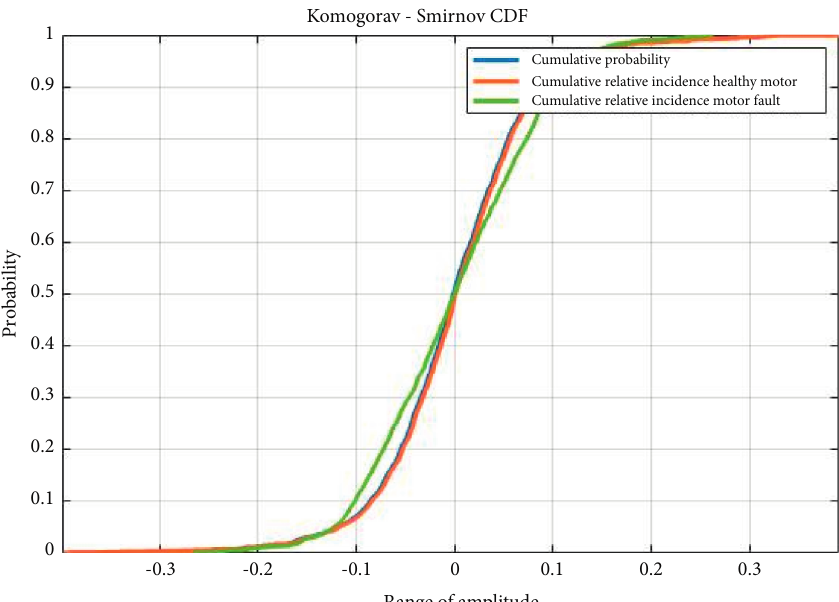
Figure 8: Comparison of the cumulative probability with the cumulative relative frequency of a healthy motor and a faulty motor using the Kolmogorov–Smirnov test.